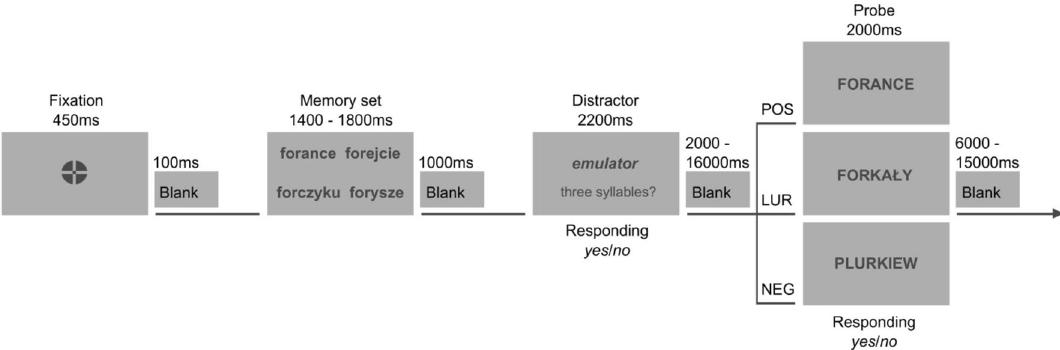
Figure 1. The sequence of stimuli in the task with an example set of pseudowords and distractor. POS positive probe, LUR lure probe, NEG negative or four syllable words. As distractors we used low frequency words in Polish language based on the dictionary by Kazojc (2011) 57 . Each participant performed the task twice—during morning (MS) and evening (ES) sessions in a 3 T Sie- mens Magnetom Skyra MRI scanner. Counterbalancing took place allowing all four possible pairing between the two task versions (A and B) and the two sessions (MS and ES) across participants, in a manner that half of participants performed version A in the morning and version B in the evening, whereas the opposite was true for the other half of participants. The possibility of the practice effect was rejected, no differences were found in both the error ratio and the reaction times between the first session held for each participant (MS or ES) and ing phase), depending on the number of syllables (two, three or four syllables, respectively). 1000 ms followed offset of the memory set, then a distractor item (word) appeared at the center of the screen for 2200 ms. An